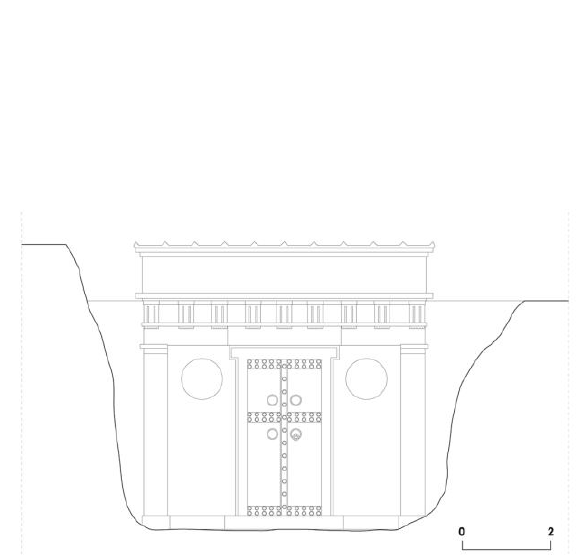
Figure 19. The Tomb of Alexander IV at Verghina. Survey.